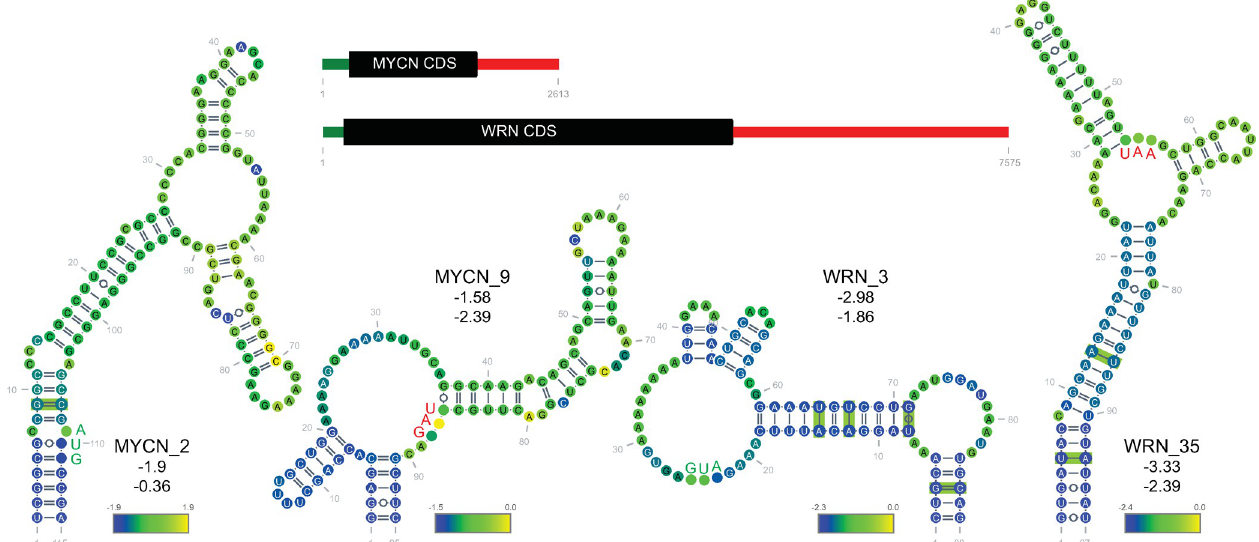
Fig 2. Examples of ScanFold identified structures that overlap the start and stop codons. The neuronal myelocytomatosis ( MYCN ) and Werner’s helicase ( WRN ) transcript diagrams are shown with secondary structures diagramed below. The AUG start codons are shown in green while the stop codons are shown in red. The multi-coloration of the bases represents the per nucleotide z-score mean as generated from ScanFold scanned windows; the scale is indicated. Base pairs boxed in green were found to be covarying after CMbuilder analysis. Values of the structure z-score (not the average of per nucleotide windows) and the Zcm are provided under the structure names,